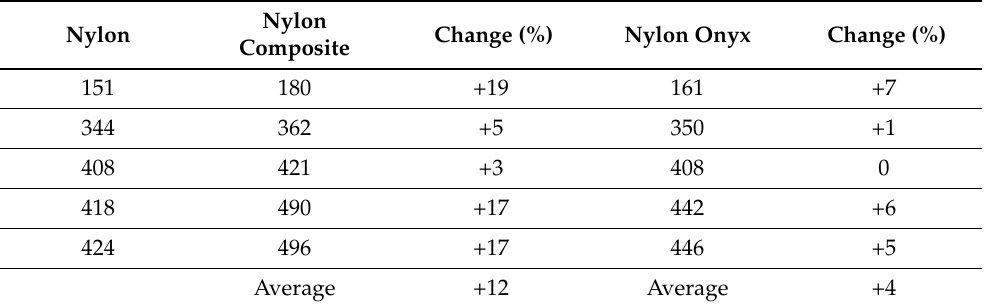
Table 7. First five natural frequencies of honeycomb lattice structure in the side-clamped boundary condition and the paired modes when the material of vertical parts of honeycomb lattice structure changed to composite or onyx.